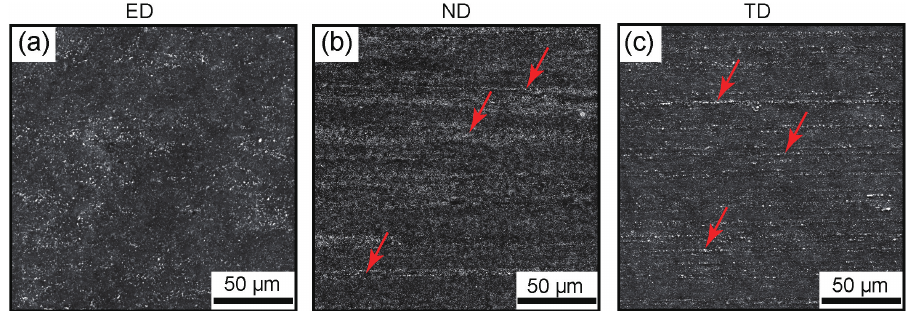
Figure 1. ( a – c ) SEM micrographs of the CNT/2024Al composite after electrolysis along three different directions as noted. White stripes marked by red arrows are oxidate-rich areas.